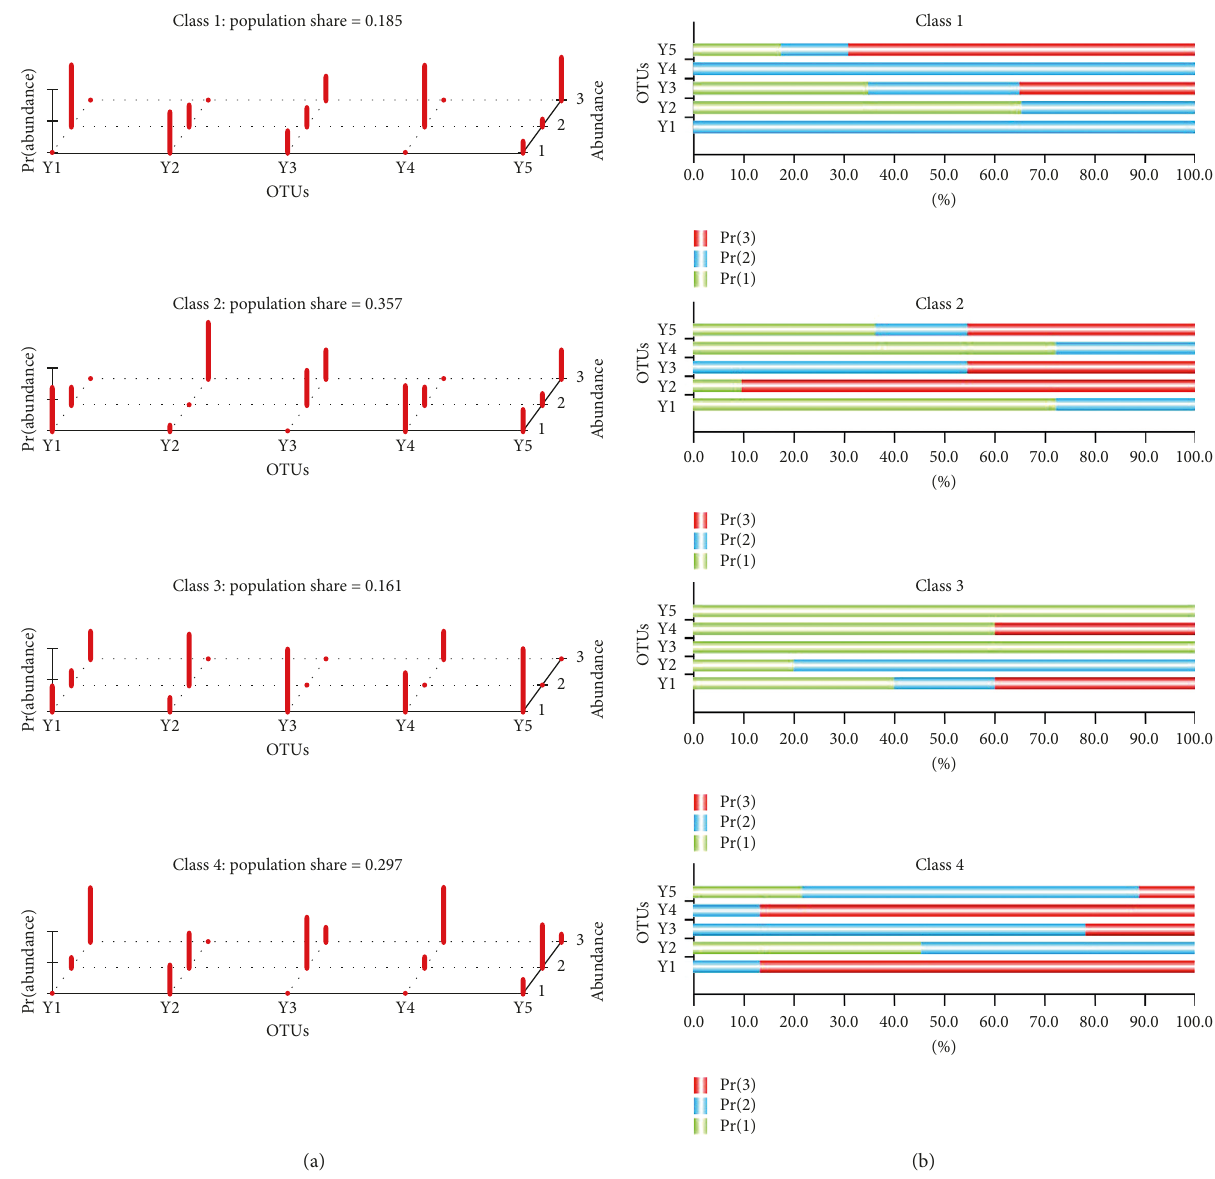
Figure 6: Latent variable analysis based on five bacteria. (a) 3D plot of the latent model. In the OTU axis, Y1, Y2, Y3, Y4, and Y5 indicate five bacteria: s_Prevotella_copri , s_Bacteroides_stercoris , f_Prevotellaceae , g_Bacteroides (OTU_736), and g_Bacteroides (OTU_1112). In the abundance axis, 1, 2, and 3 indicate three levels of absolute abundance ( < 33rd percentile, > 33rd percentile and < 66rd percentile, and > 66rd percentile), respectively. In the Pr(abundance) axis, the red bar indicates the posterior probability of five bacteria responses across the classes. (b) 2D plot of the latent model showing the same information as that of the 3D